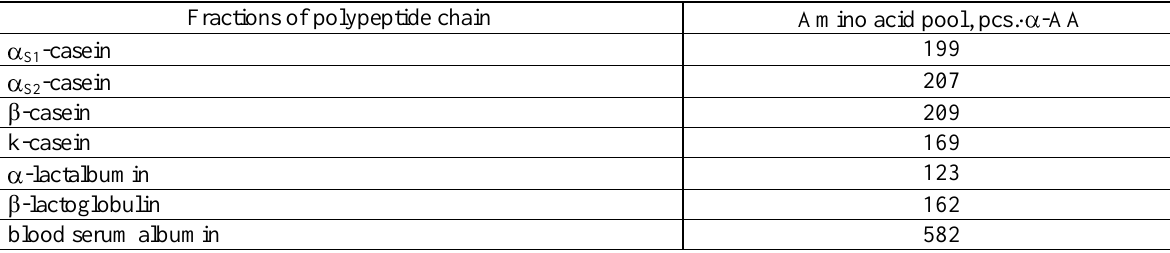
Table 3. Amino acid pool of main fractions of proteins of raw milk Fractions of polypeptide